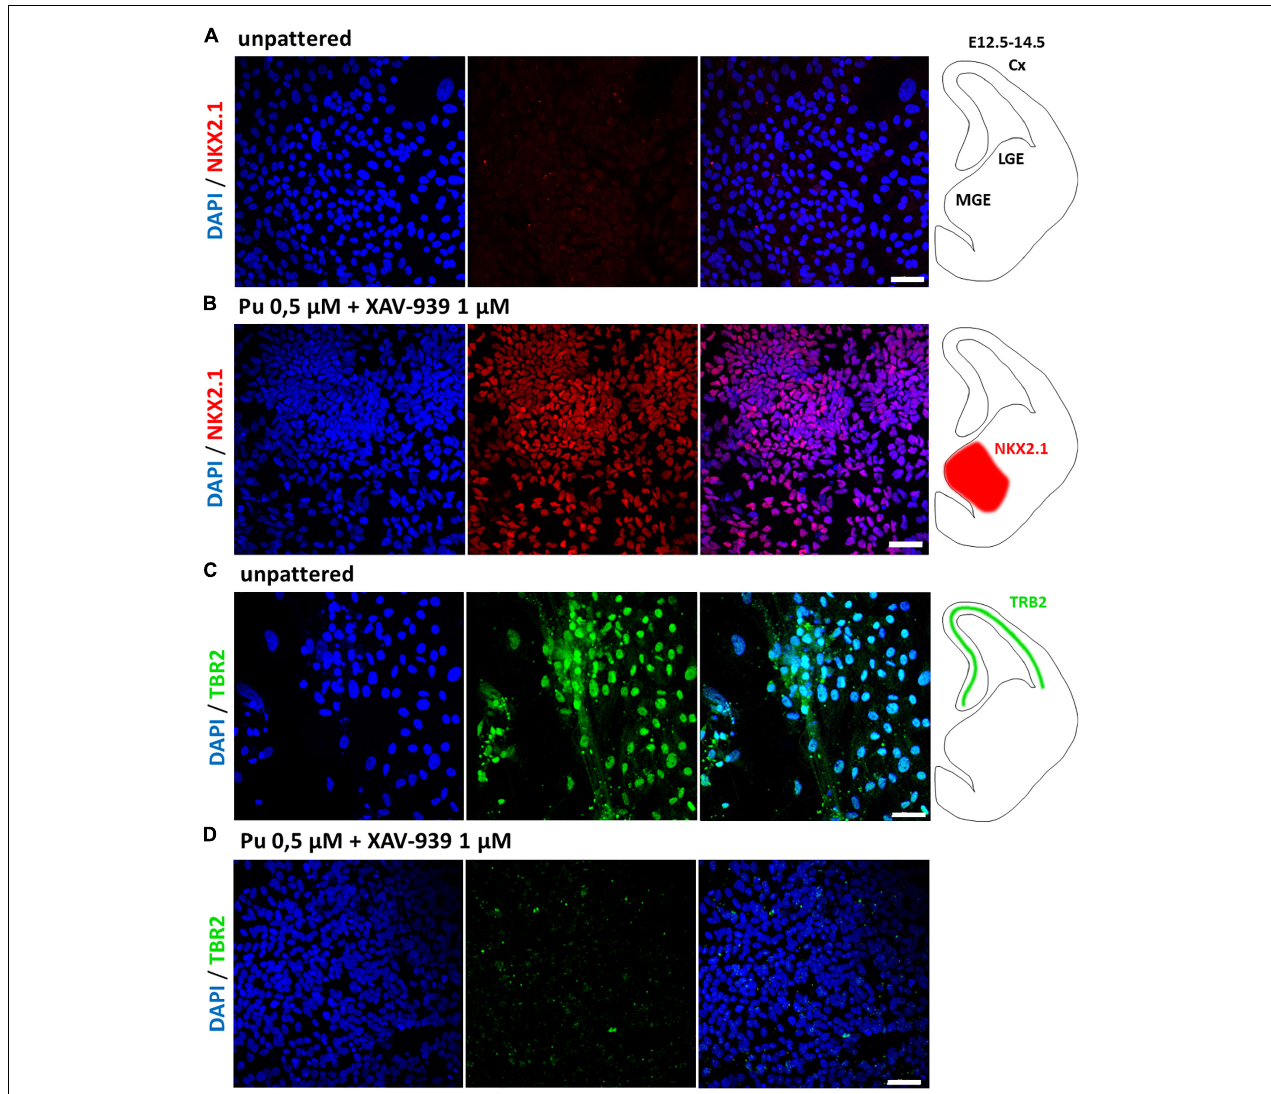
FIGURE 6 | Immunofluorescence images of 55 days in vitro (35 days after final maturation) neuronal populations. (A) In non-regionalized cells, the MGE-specific marker NKX2.1 was not detected, whereas (B) rostro-ventralized populations retained their adopted MGE identity after final maturation. (C) In contrast, the unpatterned cells exhibited a cortical identity (TBR2) which could not be identified in the rostro-ventralized populations (D) . The first panel shows nuclear staining with DAPI (blue); the second panel shows protein detection of NKX2.1 (red) or TBR2 (green); the third panel shows the overlay of the first two panels; the last column schematically shows the expression region of NKX2.1 and TBR2 in coronal sections of the left hemisphere in a 12.5–14.5-day-old mouse embryo (Englund et al., 2005; Du et al., 2008). Cx, cortex; LGE, lateral ganglionic eminence; MGE, medial ganglionic eminence. Scale bars are 40 µ